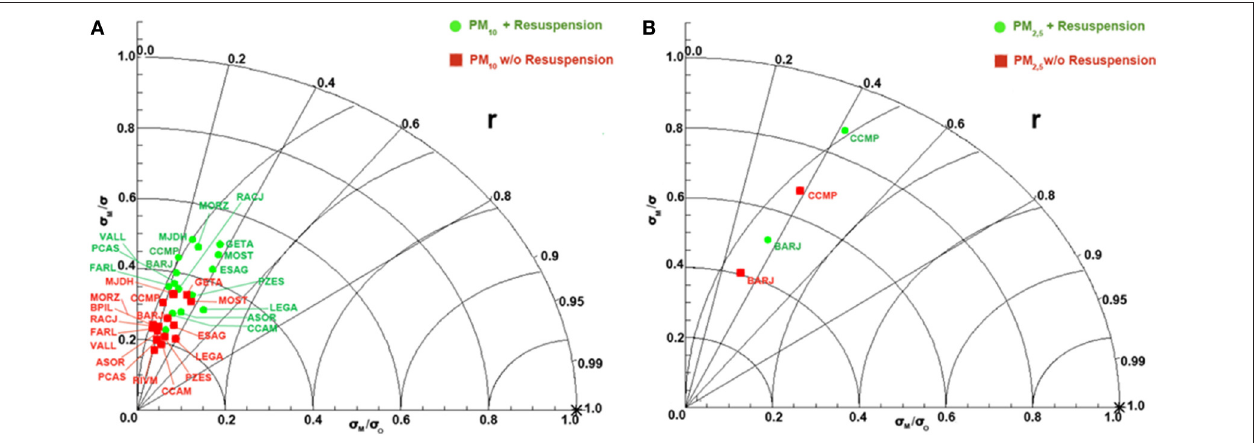
FIGURE 8 | Taylor diagrams showing CMAQ model performance for particulate matter prediction with and without implementation of resuspension: (A) results for PM 10 (B) results for PM 2.5 .